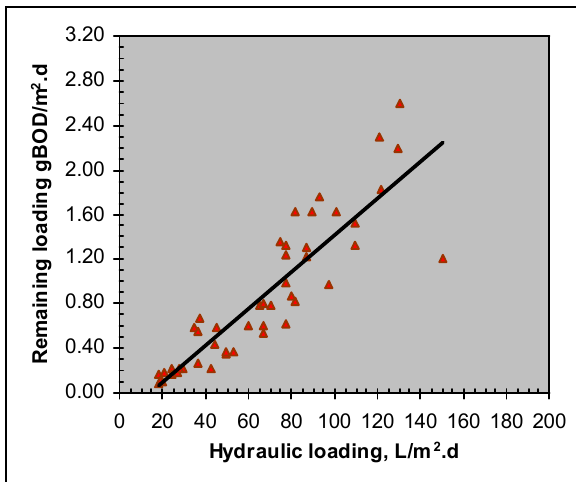
Figure 7: Effect of hydraulic loading on remaining BOD in terms of gBOD/m 2 .d